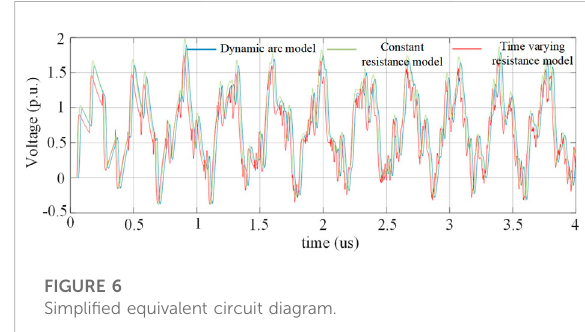
FIGURE 6 Simpli fi ed equivalent circuit